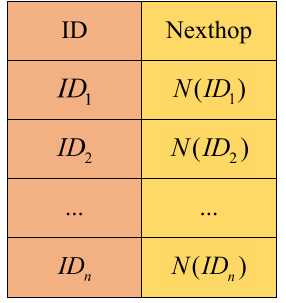
Figure 3. Dynamic next-hop table of the sink